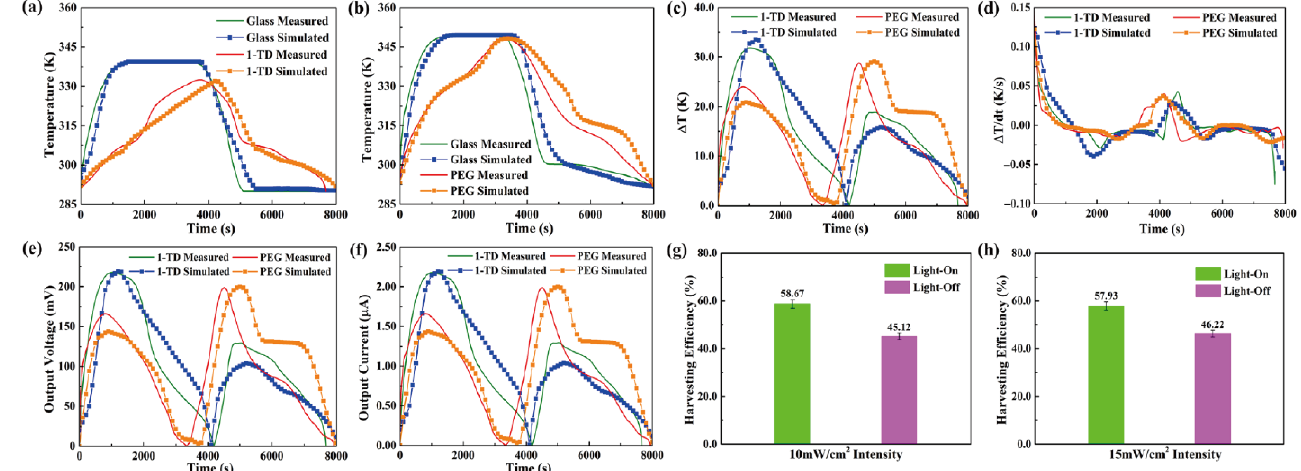
Figure 11. The experimental and simulation results of temperature peaks under ( a ) 10 mW/cm 2 and ( b ) 15 mW/cm 2 solar light intensity. ( c ) Temperature difference and ( d ) change of temperature difference in both the 1-TD and PEG composites under (10 and 15) mW/cm 2 solar light intensity, respectively. ( e ) Output electrical voltage and ( f ) output electrical current in both the 1-TD and PEG composites under 10 and 15 mW/cm 2 solar light intensity, respectively. Pyroelectric energy harvesting efficiency of ( g ) 10 mW/cm 2 and ( h ) 15 mW/cm 2 solar light intensity upon the light-on/off process.